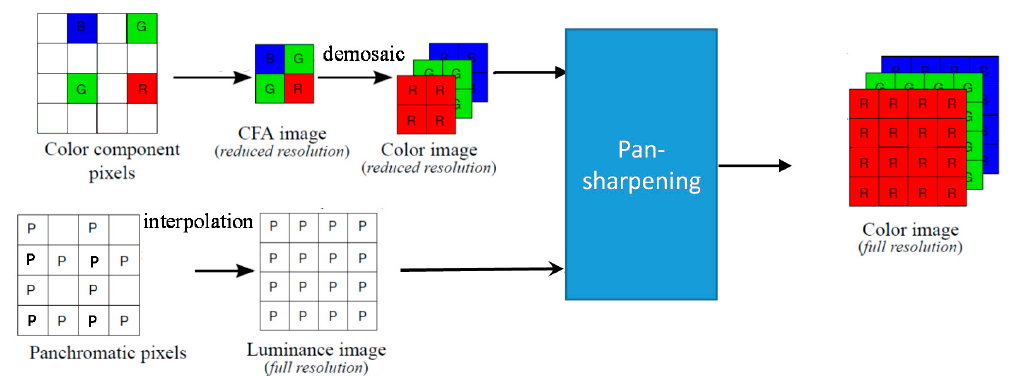
Figure 3. A pan-sharpening approach for CFA 3.0.